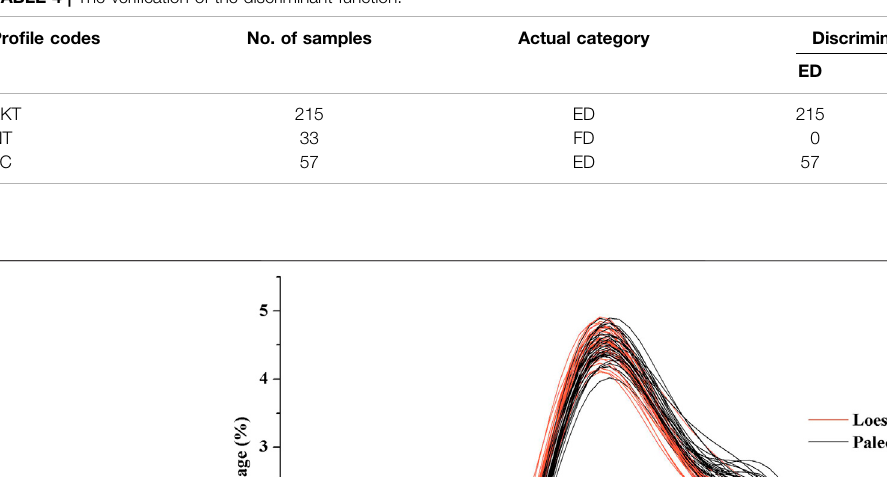
TABLE 4 | The veri fi cation of the discriminant function.